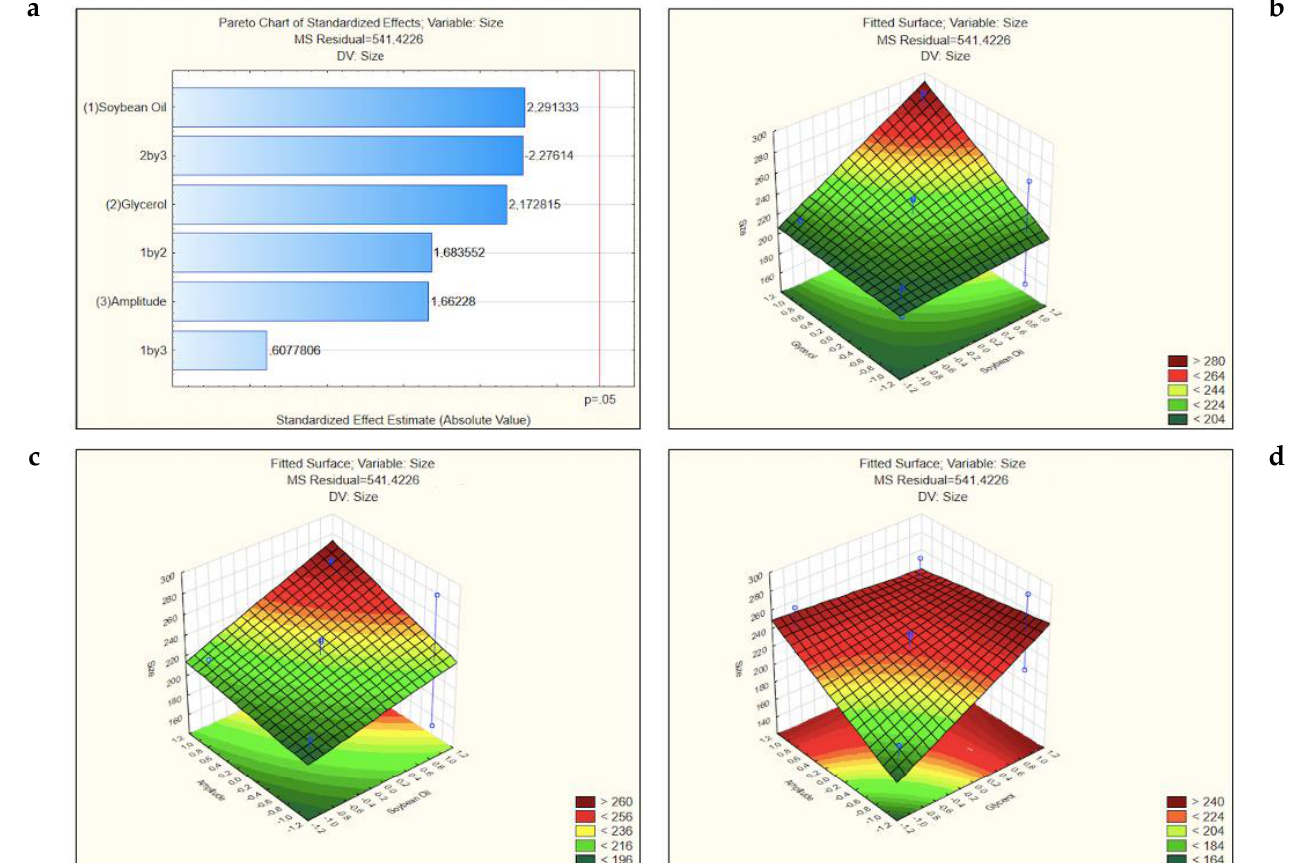
Figure 2. Pareto chart ( a ) and surface response graphs of the influence of the concentration of the glycerol and soybean oil ( b ), of soybean oil and amplitude ( c ) and of glycerol and amplitude ( d ) on the particle size.